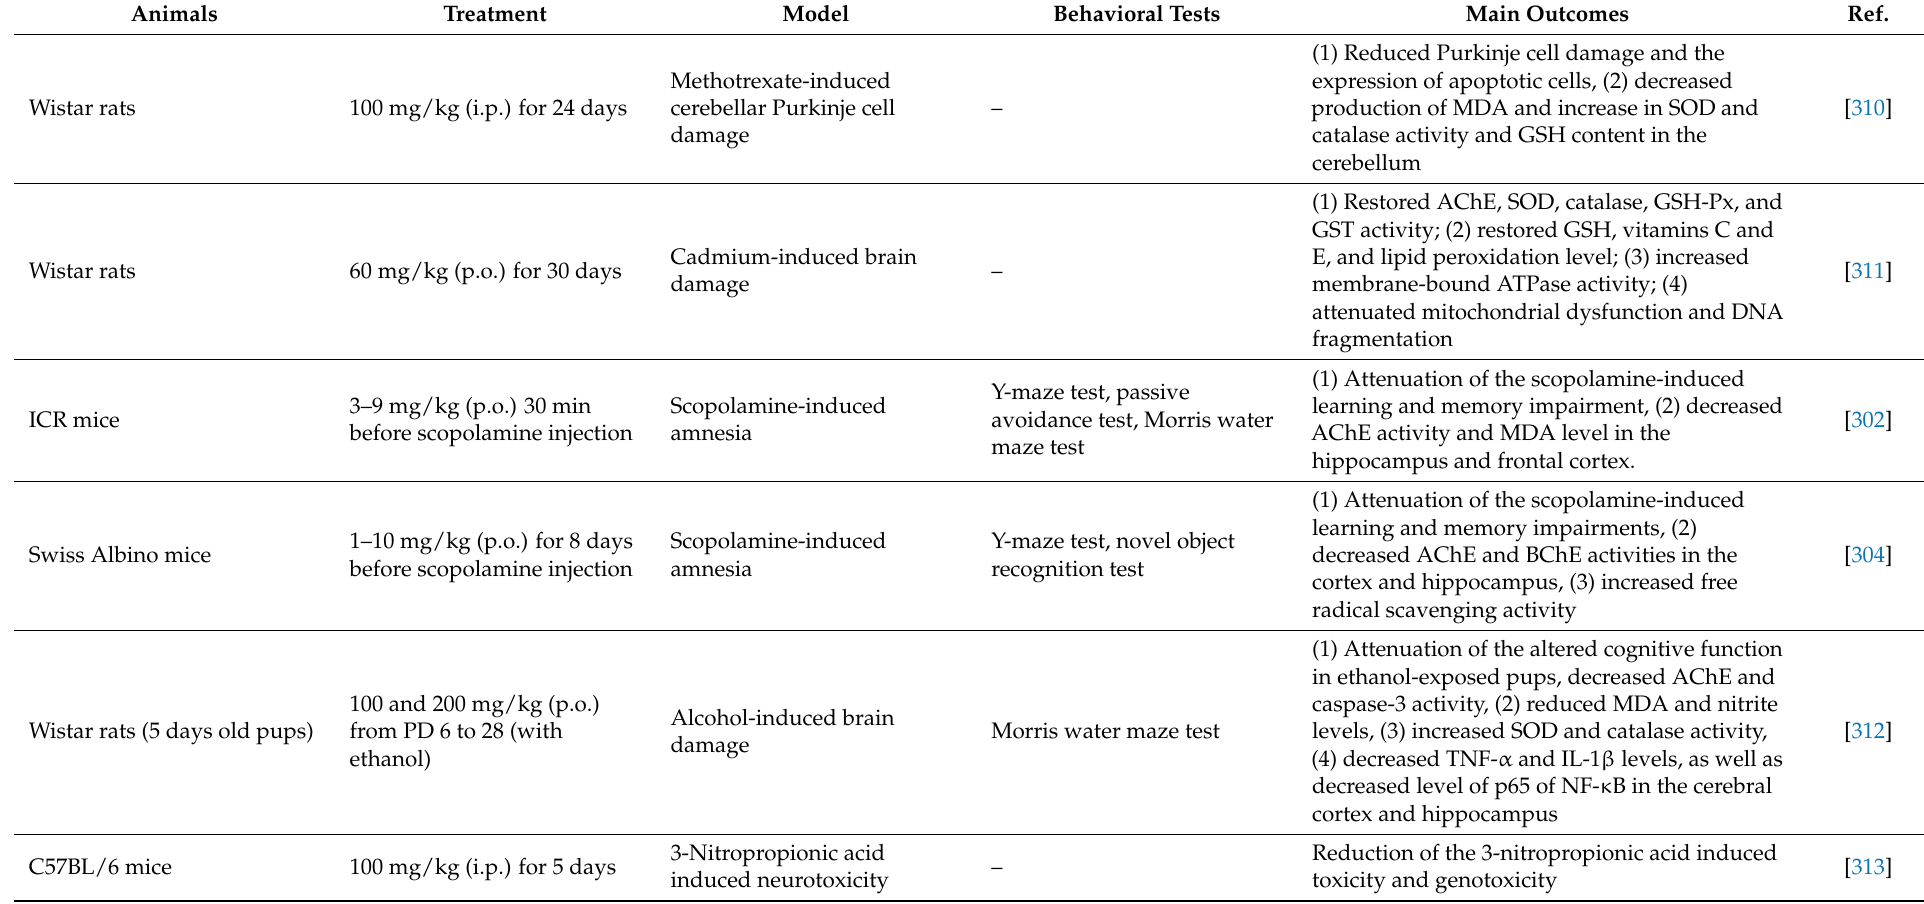
Table 4. Summary of in vivo studies on the neuroprotective effects of chlorogenic